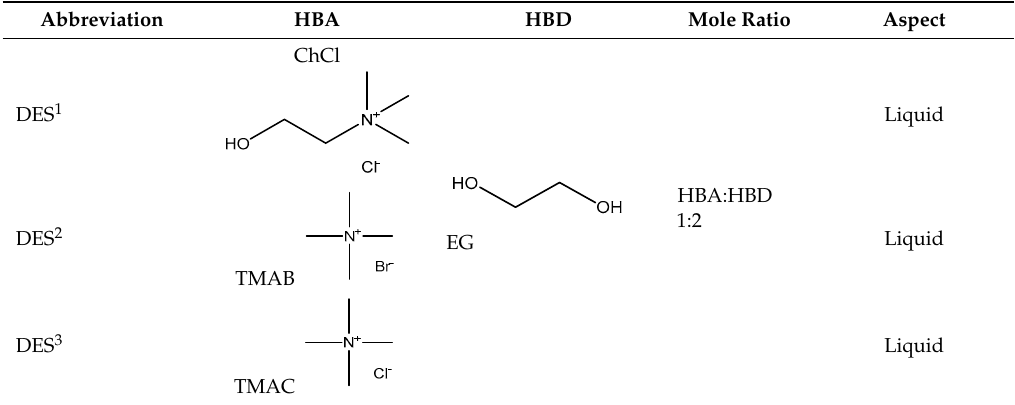
Table 1. The details of synthesized hydrophilic deep eutectic solvents (DESs).